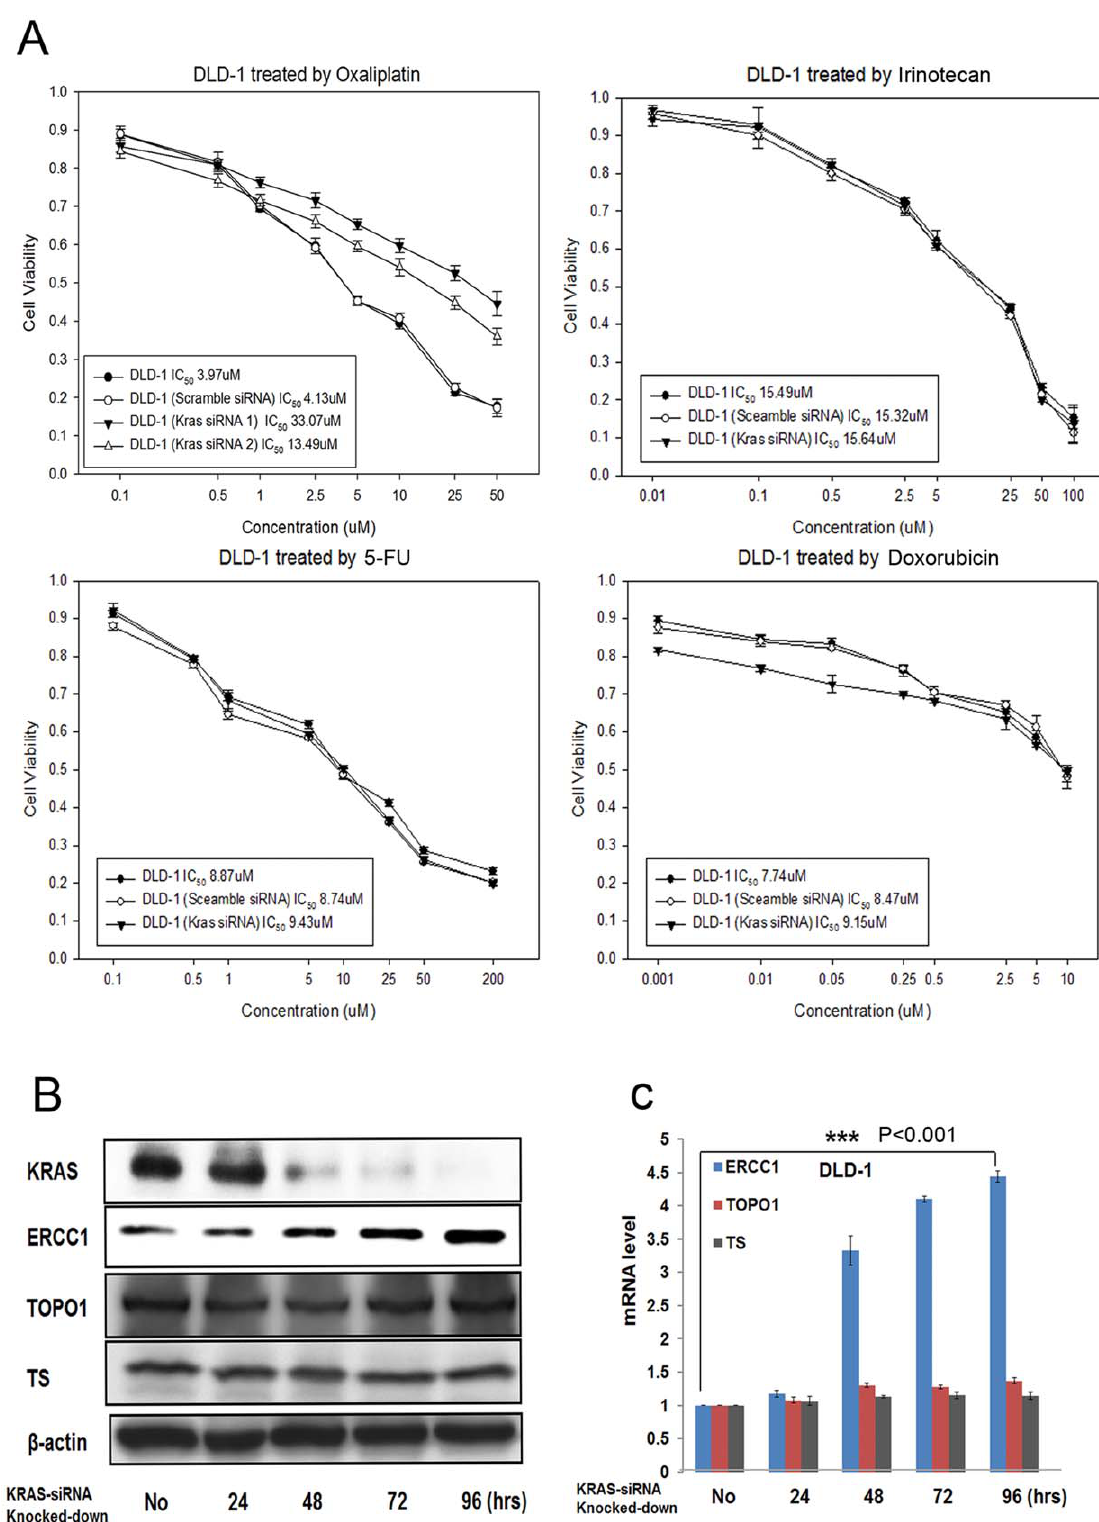
Figure 1. Knocking down KRAS expression in KRAS-mutant (G13D) CRC cells confers oxaliplatin resistance and ERCC1 upregulation. (A) KRAS-knocked-down DLD-1 G13D cells were more resistant to oxaliplatin, but have the same sensitivity to irinotecan, 5FU, and doxorubicin than parental DLD-1 G13D cells, as demonstrated by MTT assay. (B) The protein level of ERCC1, but not those of TOPO1 or TS, was upregulated after DLD-1 G13D cells were knocked-down by KRAS siRNA. (C) The mRNA level of ERCC1, but not those of TOPO1 or TS, was upregulated after DLD-1 G13D cells were knocked-down by KRAS siRNA. ***: p , 0.001.